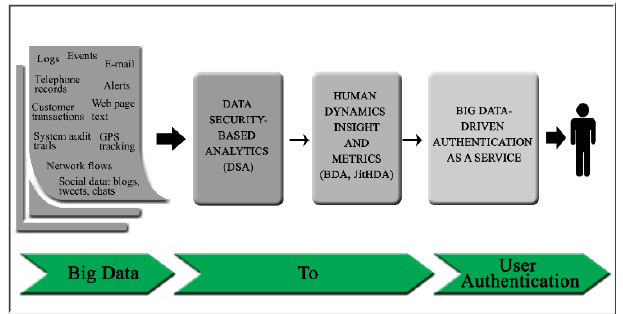
Figure 1. The components of Dr. Ouda’s authentication framework